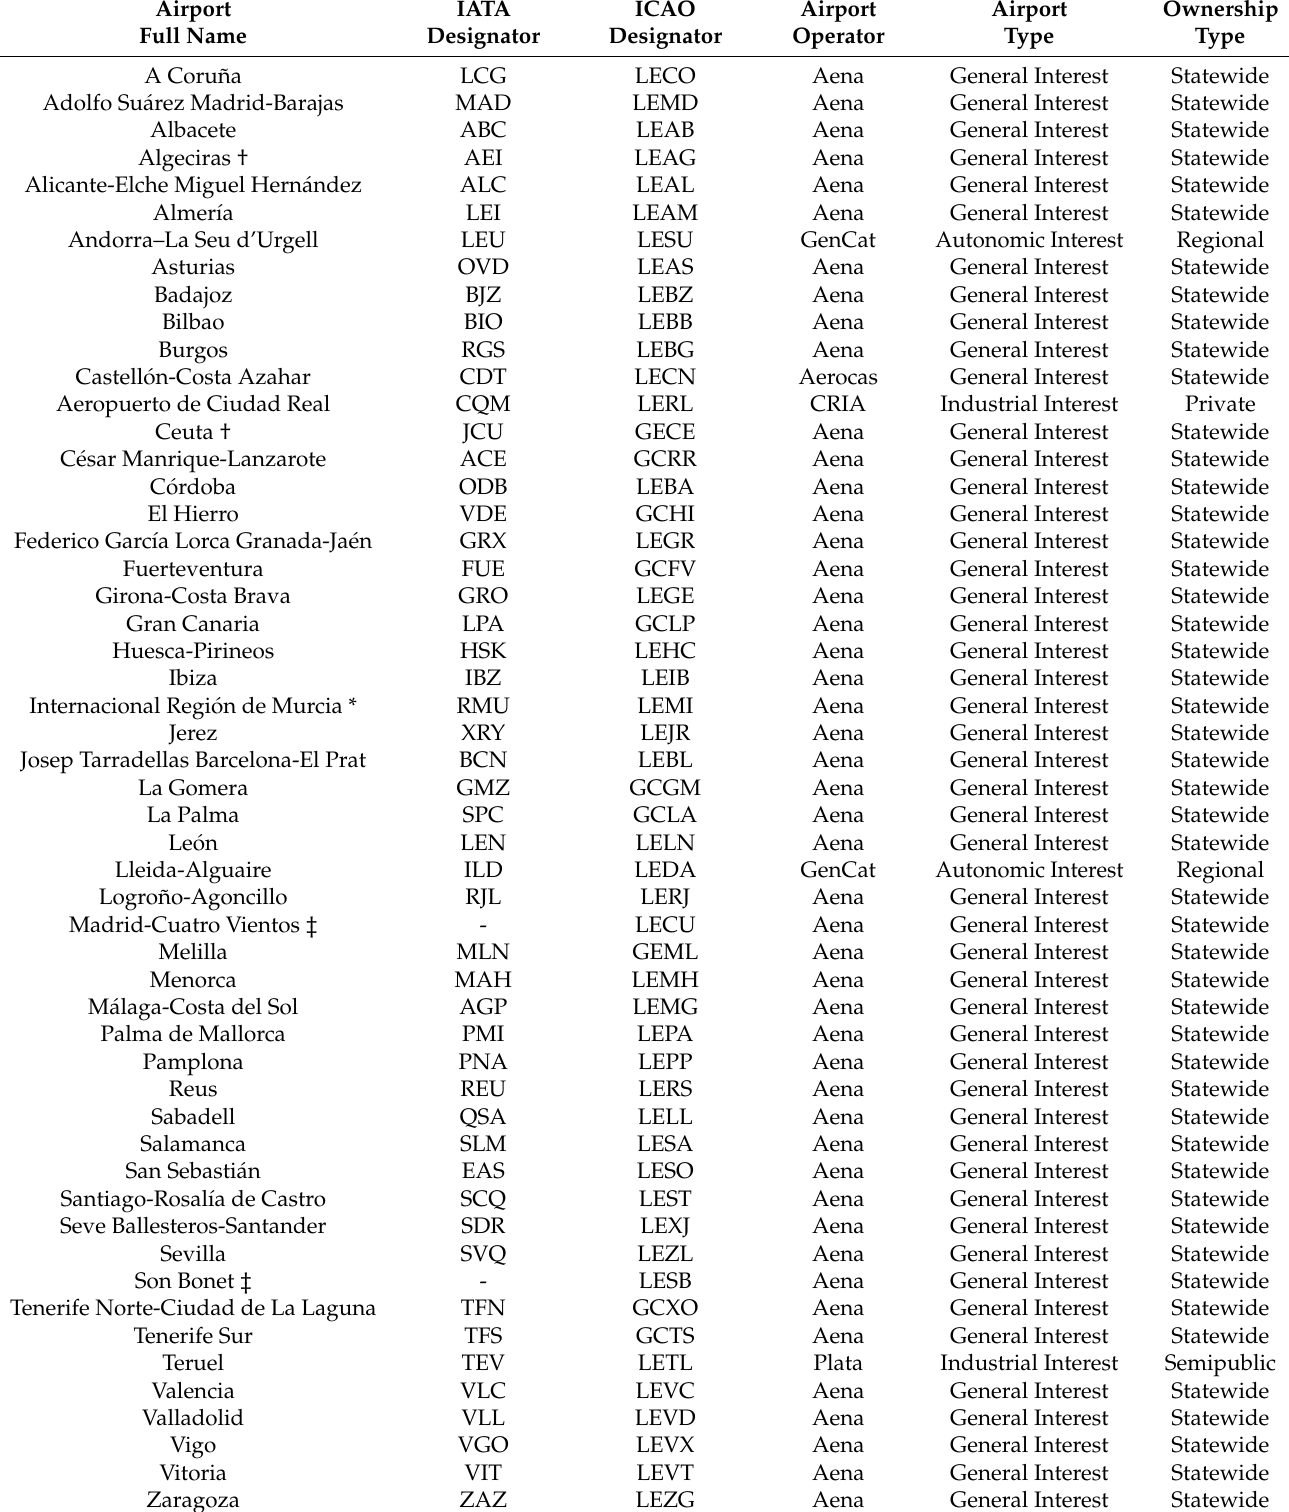
Table 2. Existing civil air facilities in Spain (as of 14 November